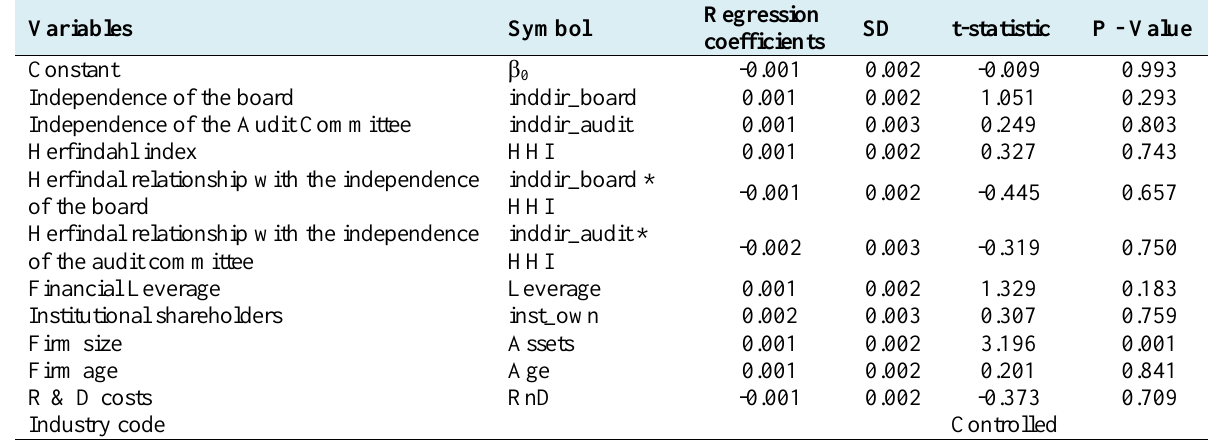
Table 5 . Results of fitting the model related to the first criterion of opinion shopping (a simultaneous increase of audit fee and change from industry specialist auditor to the non-specialist auditor)